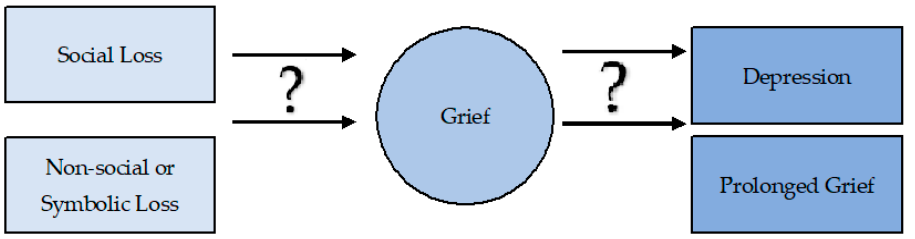
Figure 1. This model underlines the mediating factor that should be in question to determine associations between types of loss, grief, and psychopathologies.